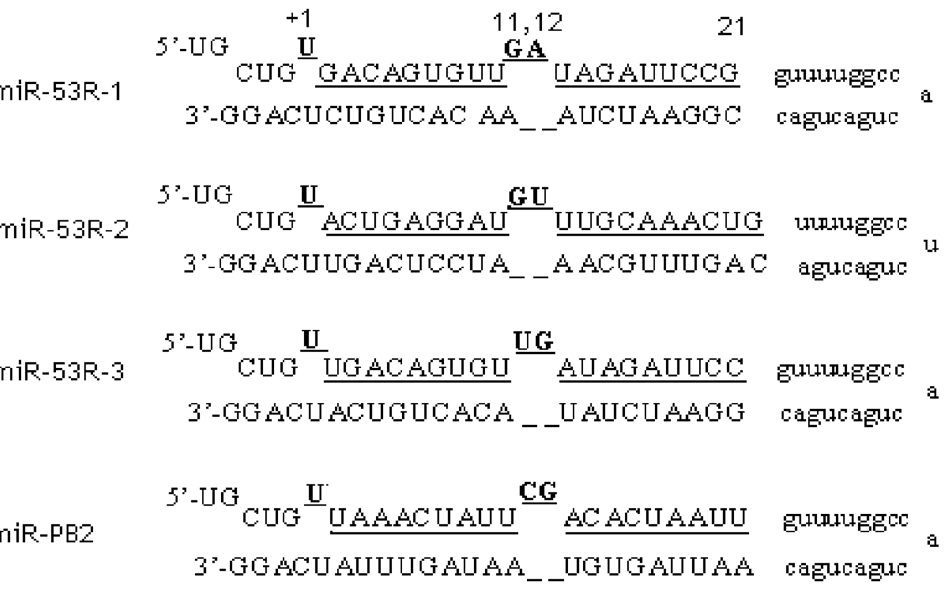
Figure 1. Schematic presentation of predicted stem-loop sequences of pSM155-amiR-53Rs. + 1, 11, 12 and 21 are corresponded to positions in stem structure. The antisense of the target sequences for the ORF of 53R and the 3 9 UTR of PB2 are underlined.